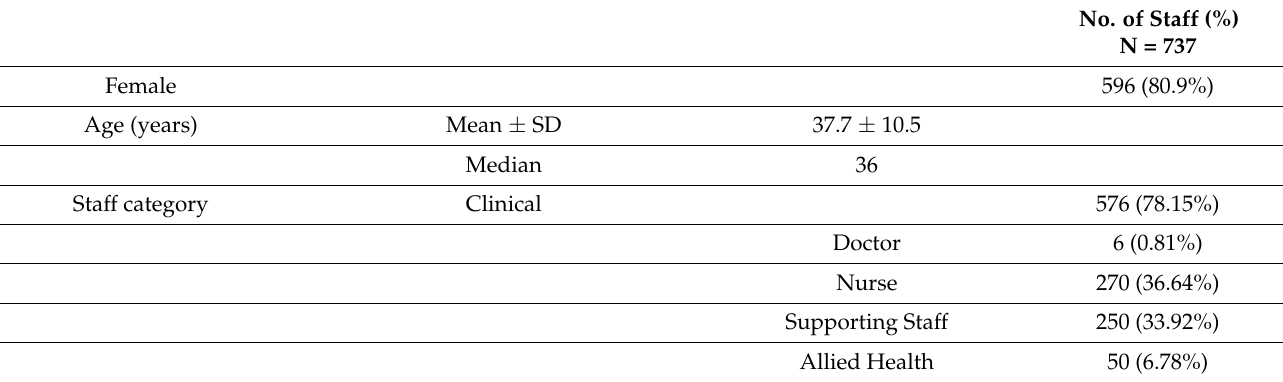
Table 2. Demographics and symptoms of staff with COVID-19 during the study